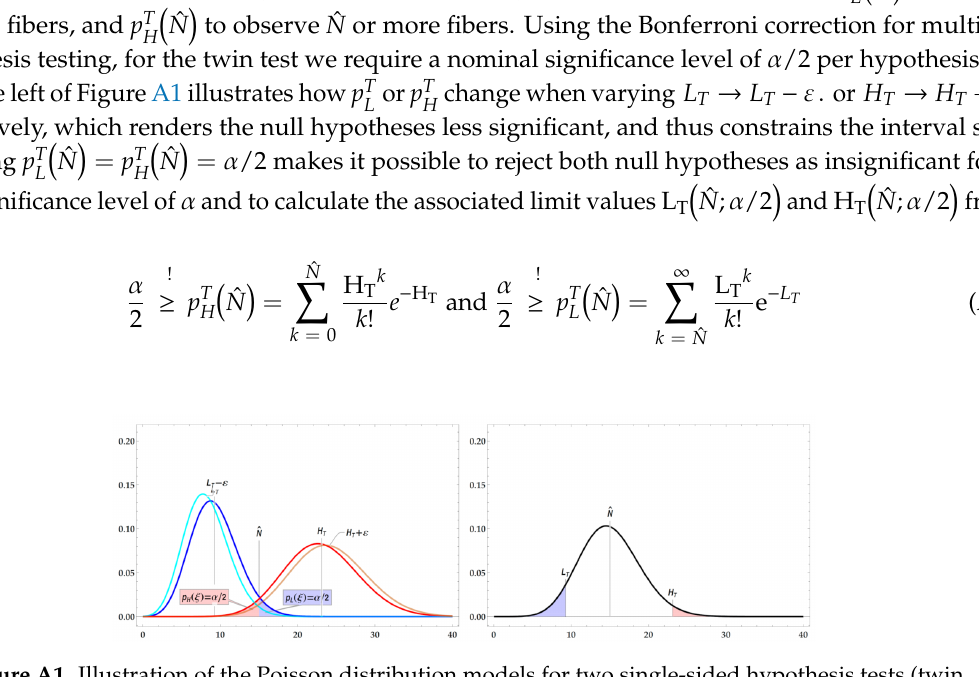
Figure A1. Illustration of the Poisson distribution models for two single-sided hypothesis tests (twin test) with associated p -values ( left ) and resulting probability interval ( right ) for the case of ˆ N = 15 observed fibers, a nominal significance level α = 10 % and ε =